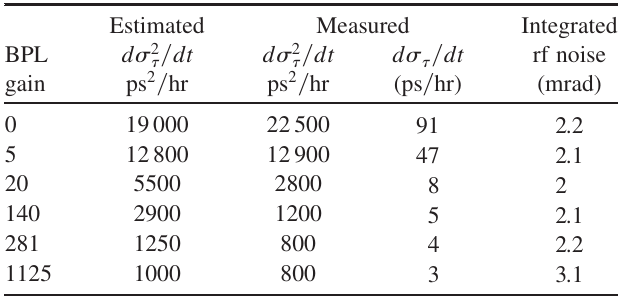
(cid:3) f s . Horizontal rev